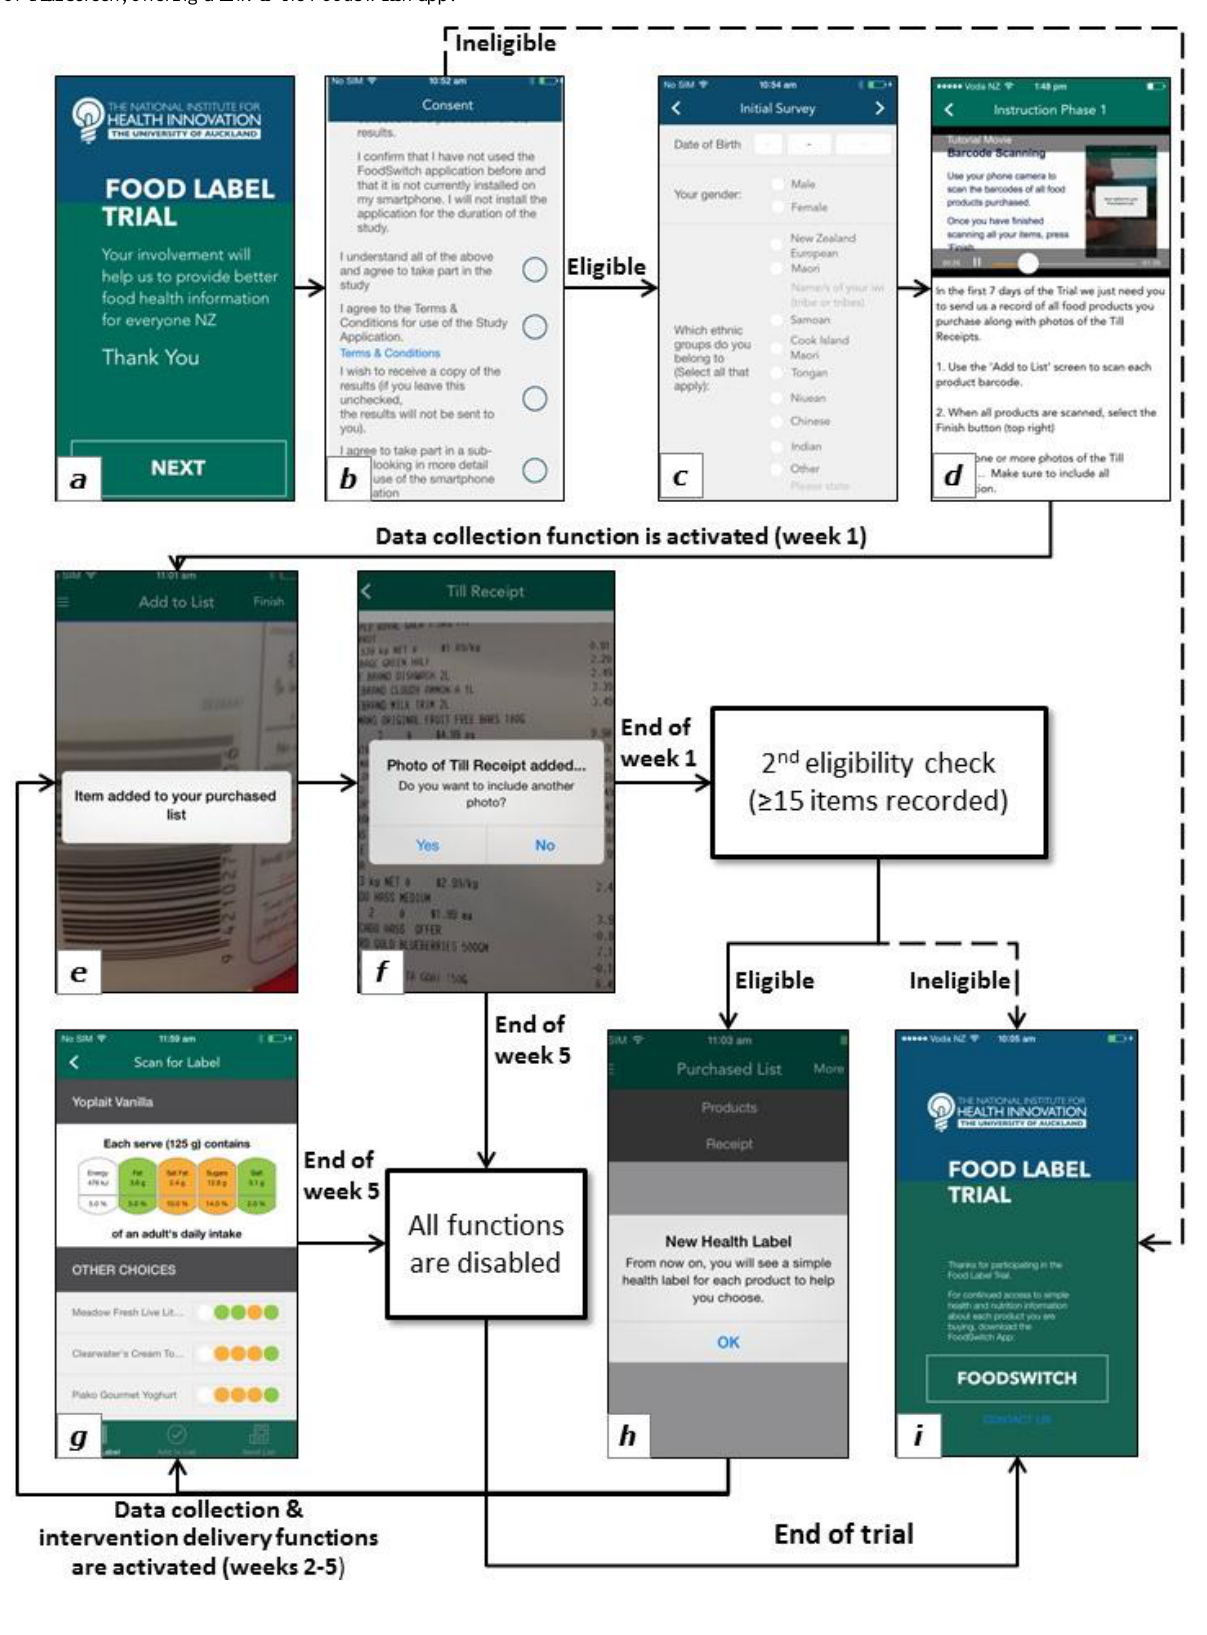
Figure 3. Food Label Trial app key functionality flowchart with sample screenshots (from the New Zealand version of the app). (a) Welcome screen. (b) Consent and terms and conditions screen. (c) Baseline questionnaire screen. (d) Tutorial. (e) Data collection mode: barcode scanning. (f) Data collection mode: adding a matching till receipt image. (g) Intervention delivery: traffic light label arm. (h) Postrandomization in-app notification. (i) End of trial screen, offering a link to the FoodSwitch